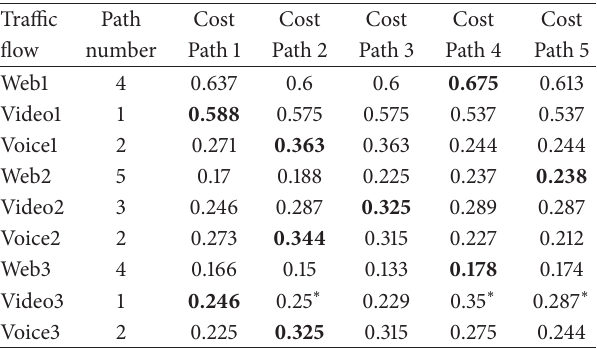
Table 6: The path selection and the actual 𝑐 𝑝 values of the currently arriving flows using FCBA.